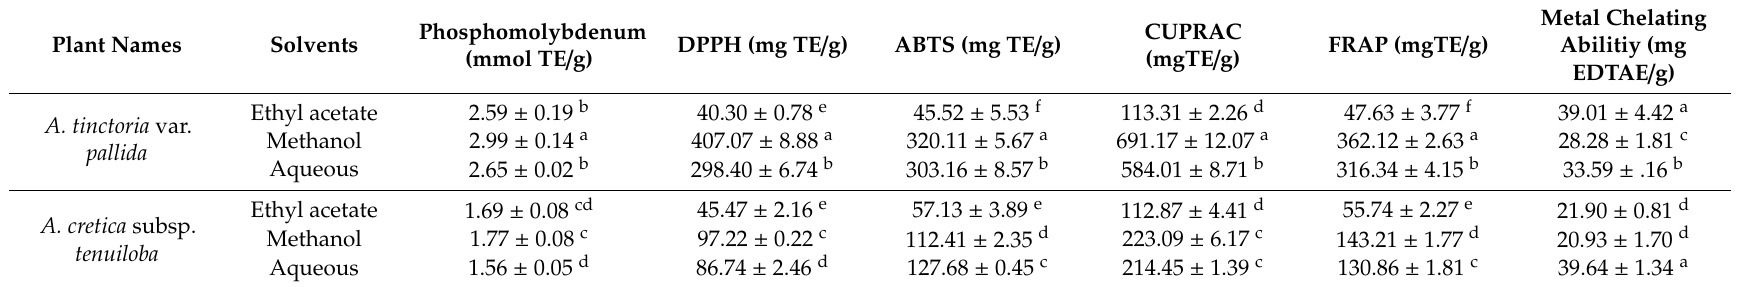
Table 3. Antioxidant properties of Anthemis extracts